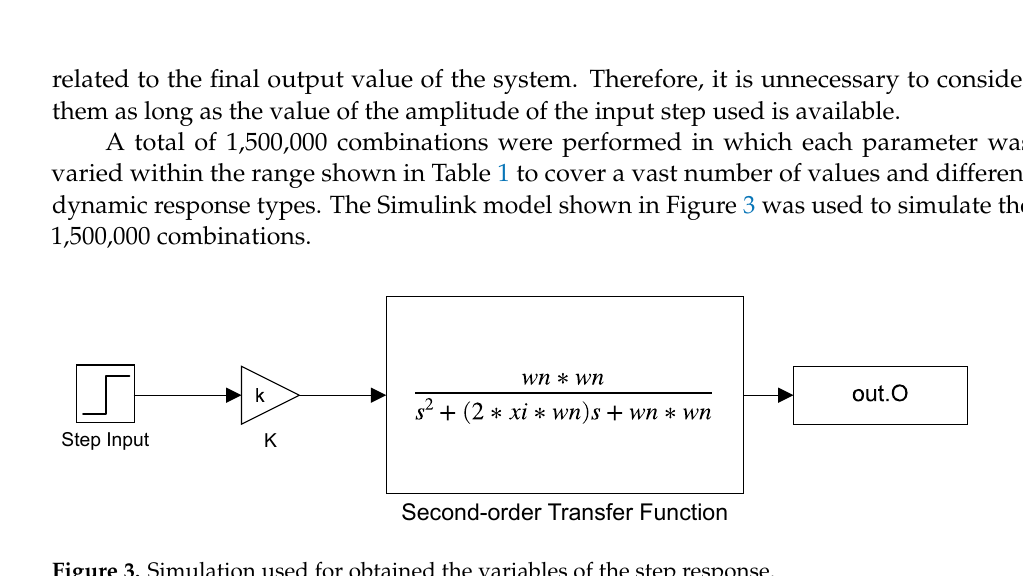
Figure 3. Simulation used for obtained the variables of the step response. Table 1. Ranges for variables used for generating the database.